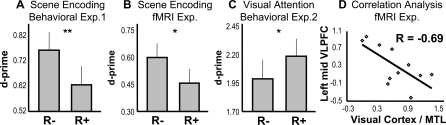
Behavioral Results and fMRI Correlation AnalysisBars showing d-primes for scene encoding or target detection during concurrent recognition hits (R+) and misses (R–) for Behavioral Experiment 1 (A), fMRI Experiment (B), and Behavioral Experiment 2 (C).Note: * p-value < 0.05 and ** p-value < 0.005, and the error bars represent SEM.(D) Scatterplot showing the correlation between activity in left mid-VLPFC and the encoding suppression in the visual cortex/MTL. Each point represents the data from a single participant.